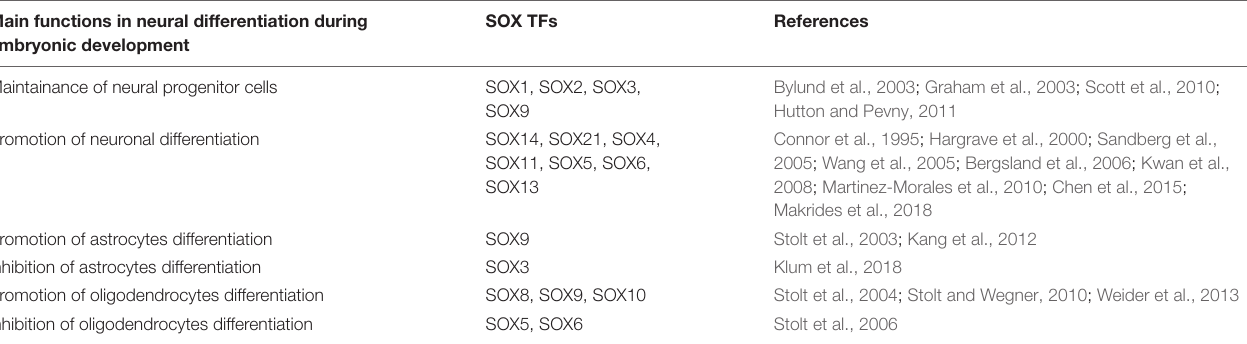
FIGURE 7 | Interaction between SOX TFs and miRNAs during neural differentiation from neural progenitors to neurons, astrocytes or oligodendrocytes. Interaction between SOX TFs and miRNAs involved in differentiation of neurons from NPCs is shown within purple frame (Cheng et al., 2009; Peng et al., 2012; Cimadamore et al., 2013; Kamachi and Kondoh, 2013; Morgado et al., 2016; Li et al., 2019). Interaction between SOX TFs and miRNAs involved in differentiation of astrocytes from NPCs is shown within red frame (Krichevsky et al., 2006; Zhou et al., 2018), while interaction between SOX TFs and miRNAs involved in differentiation of mature oligodendrocytes from oligodendrocytes progenitors is shown within orange frame (Dugas et al., 2010; Zhao et al., 2010; Gokey et al., 2012; Hoffmann et al., 2014; Reiprich et al., 2017; Nazari et al., 2018; Afrang et al., 2019; Wittstatt et al., 2020). TABLE 2 | Main functions of SOX TFs in neural differentiation during embryonic